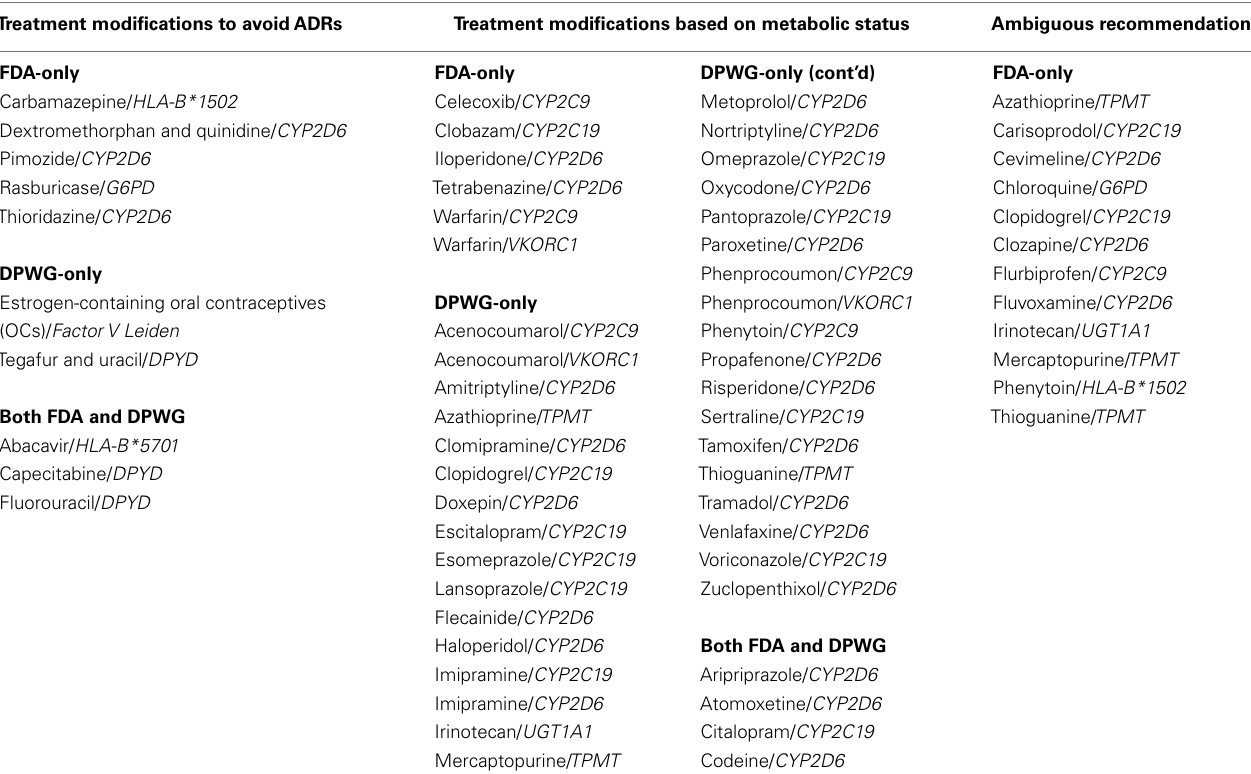
Table 2 | Drug-gene pairs with therapeutic recommendations in FDA drug labels and the Dutch PharmacogeneticsWorking Group (DPWG)